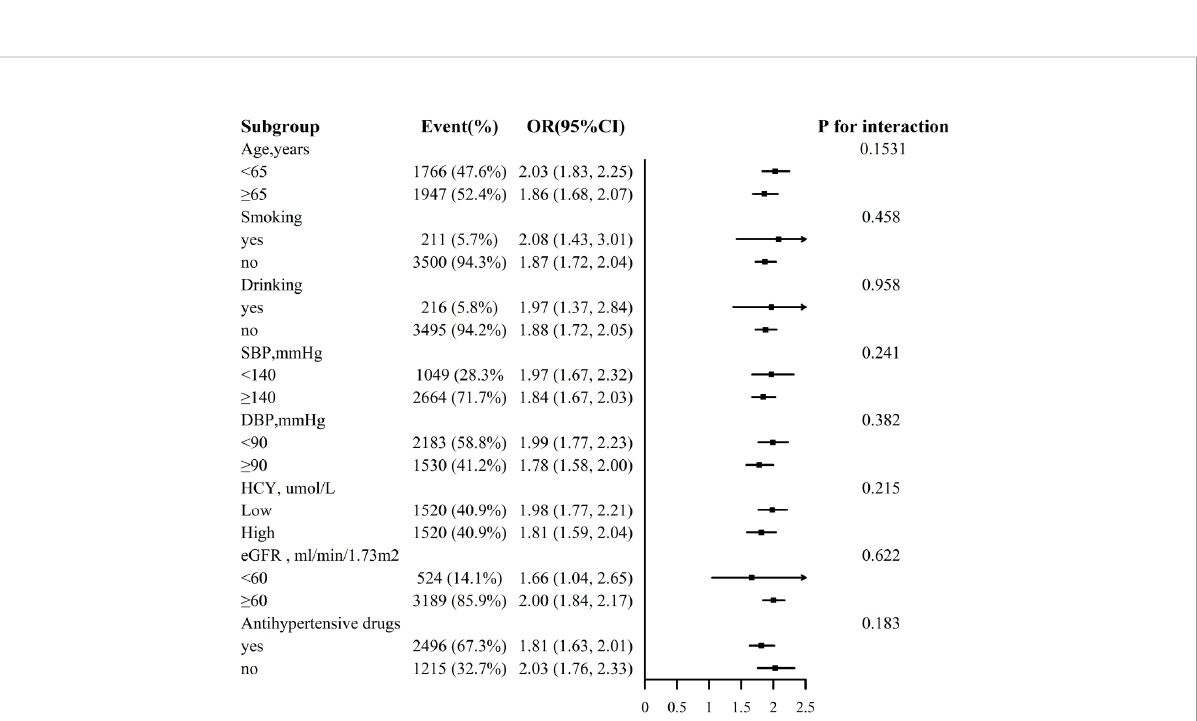
FIGURE 4 Association between ln VAI and hyperuricemia in females in various subgroups. The models adjusted for age, smoking, drinking, BMI, SBP, DBP, TC, LDL-C, HDL, HCY, eGFR, anti-hypertensive drugs, glucose-lowering drugs except for the